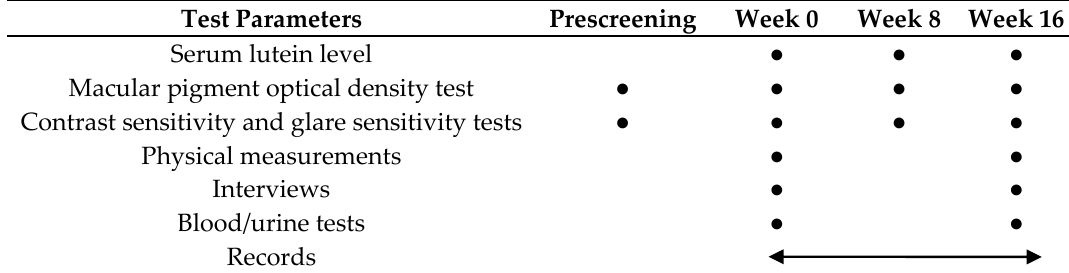
Table 2. Test parameters and testing schedule.